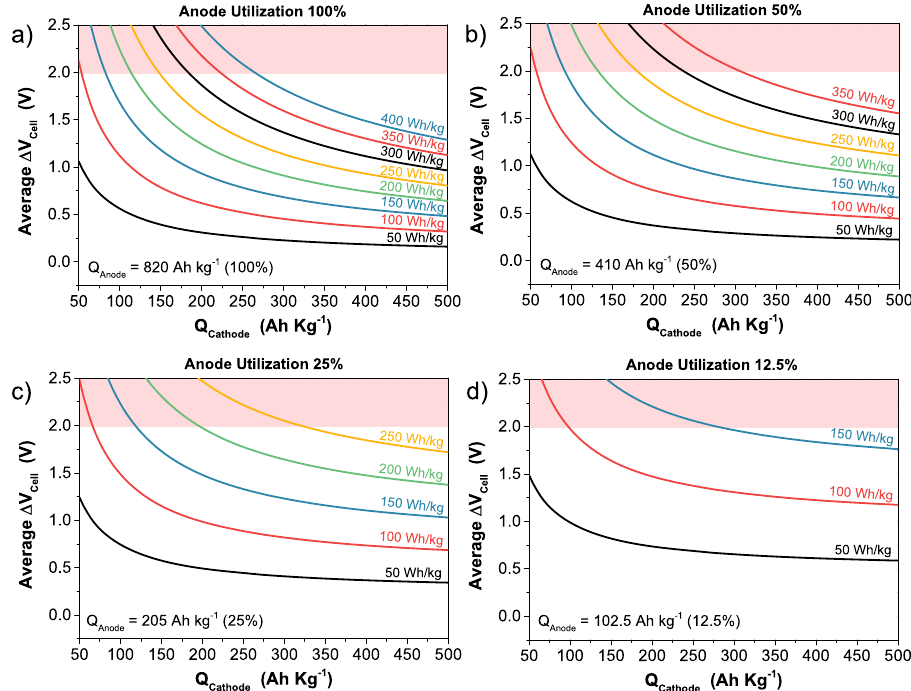
Fig. 2 Equi-energy curves of ZIBs. Equi-energy curves of a ZIB calculated from Eq. 1 as a function of the speci fi c charge capacity of a generic cathode. Each graph represents a different extent of utilization of a metallic zinc anode, namely: a 100%, b 50%, c 25%, and d 12.5%. Shaded in red is the region in which water splitting occurs, an inaccessible operating regime for